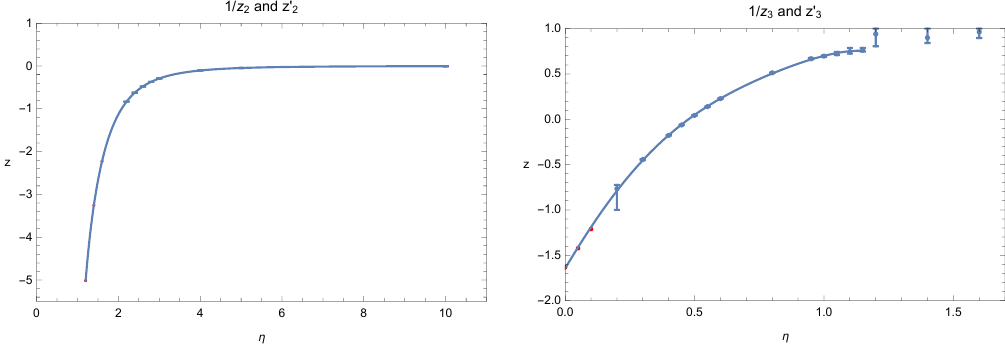
Figure 9. Left: location of the resonance zero z 0 (for η ’ 2 , blue dots) or the pole 1 /z 2 cor- 2 responding to the second lightest particle (for η / 2 , red dots, values for the several lowest η ’s are omitted for clarity) as a function of η . Right: location of the resonance zero z 0 (for η ’ 0 . 1 , 3 blue dots) or the pole 1 /z 3 corresponding to the third lightest particle (for η / 0 . 1 , red dots) as a function of η . The pole positions z 2 , z 3 are determined from the energy of 1-particle states via TFFSA. The zeros z 0 , z 0 are determined from the numerical analytic continuation of S ( z ) , with 2 3 error bars inferred from